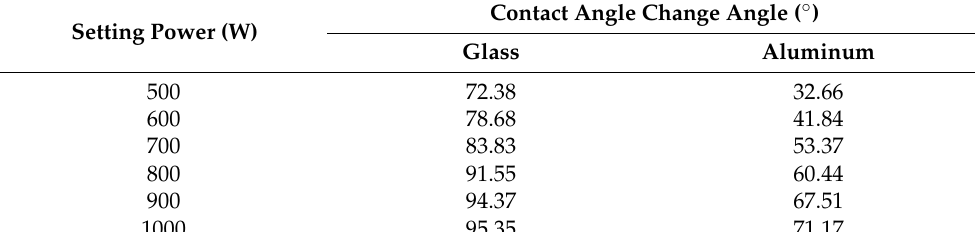
Table 6. Data sheet of glass and aluminum materials for plasma cleaning.